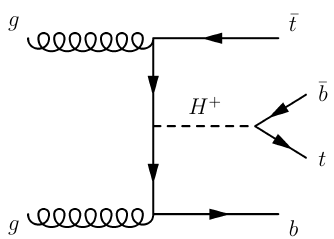
Figure 1. Leading-order Feynman diagram for the production of a heavy charged Higgs boson ( m > m t + m b ) in association with a top quark and a bottom quark ( tbH + H +